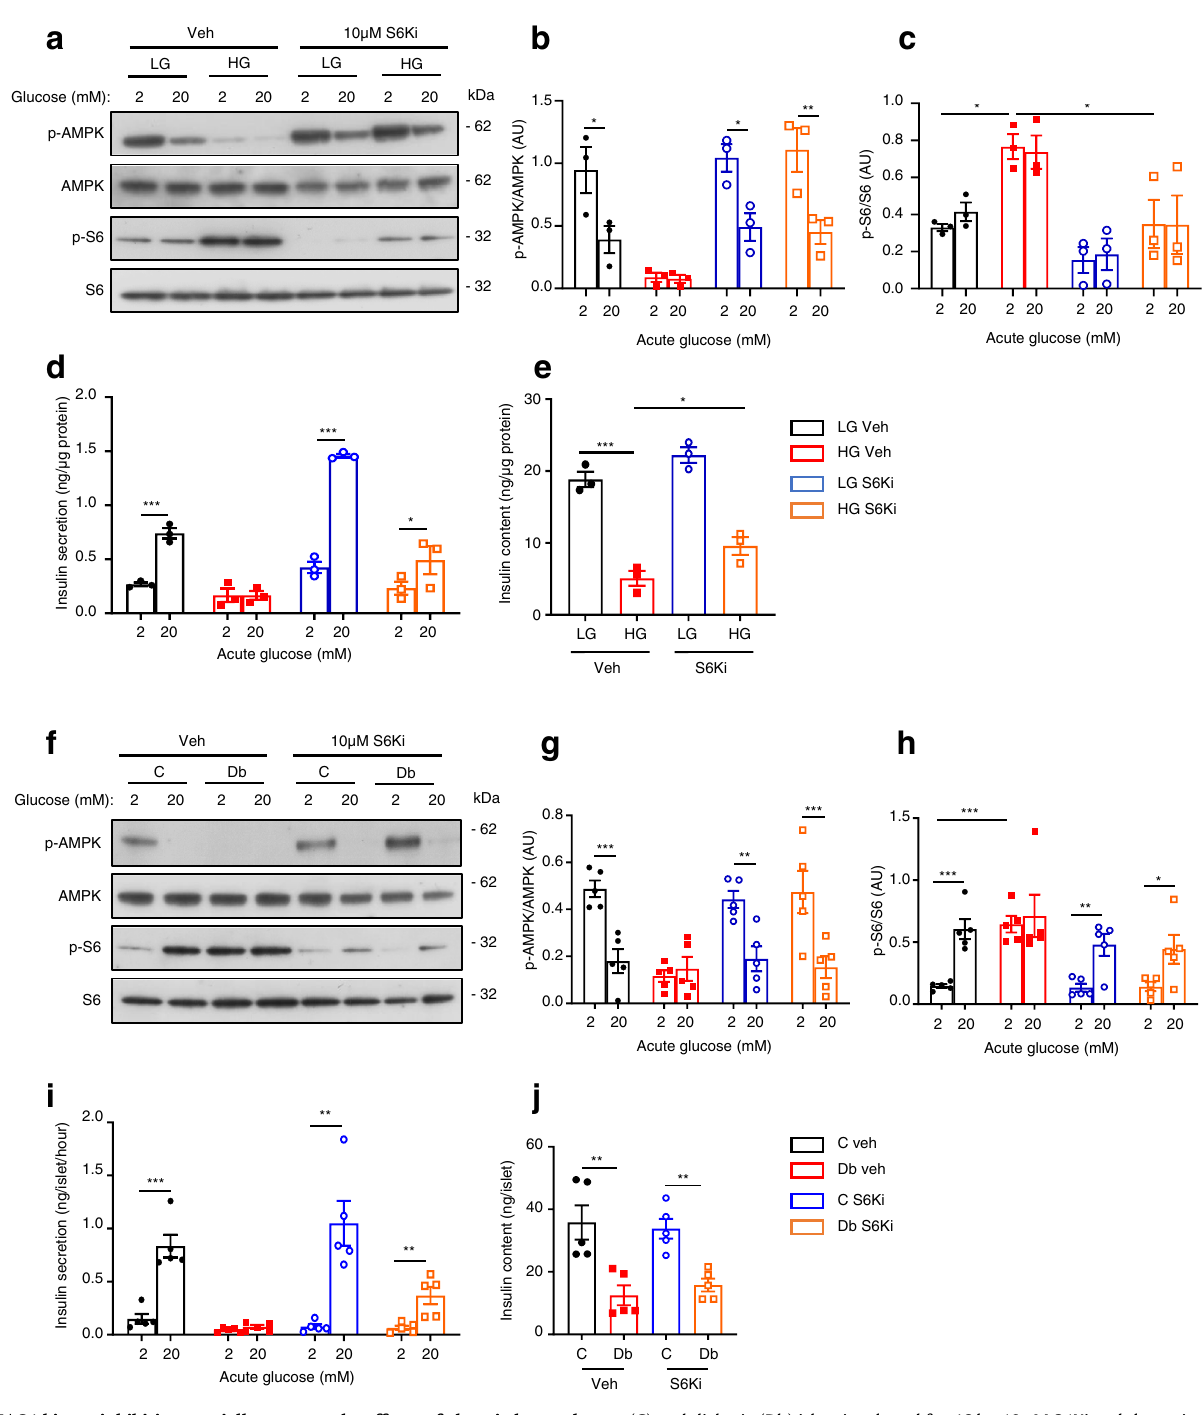
(C) and diabetic (Db) islets incubated for 48h±10 µ M S6Ki and then stimulated with2mMor20mMglucosefor1hintheabsenceofS6Ki.Phosphorylated(p)and totalAMPKandS6.Uncroppedblotsinsourcedata. g , h Quantitativedensitometry analysisof p-AMPK/AMPK ( g , n =5,13 – 16 animals/genotype) and p-S6/S6 ( h , n =5, 15 – 18 animals/genotype). Control islets (black), Diabetic islets (red), Control islets+S6Ki (blue), Diabetic islets+S6Ki (orange). i Insulin secretion and j insulin content from control and diabetic islets incubated for 48h±10 µ M S6Ki and then stimulatedwith2mMor20mMglucosefor1h( n =5animals/genotype).Allpanels show individual data points and mean±s.e.m. * P <0.05, ** P <0.01, *** P <0.001, two-tailed unpaired Student ’ s t test. Veh, vehicle (0.05% DMSO). Source data are provided as a Source Data fi